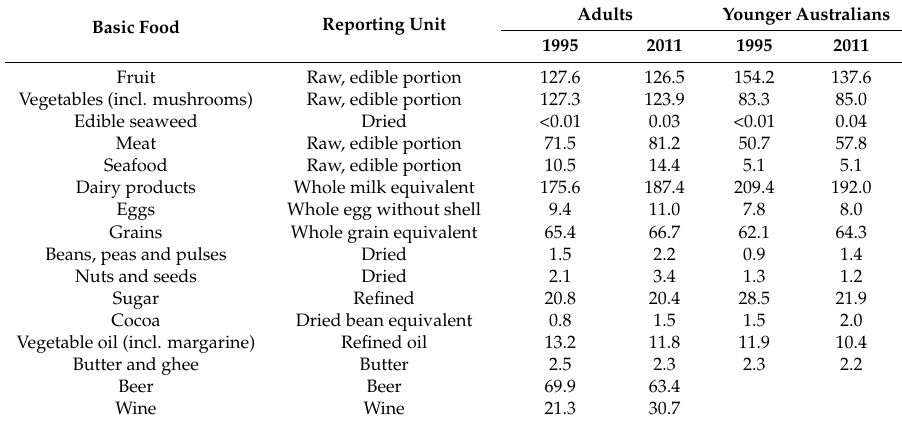
Table 1. Reported intake of basic food (kg/person/year) by adult (19 years and above) and younger Australians (2 to 18 years) in 1995 and 2011. 1